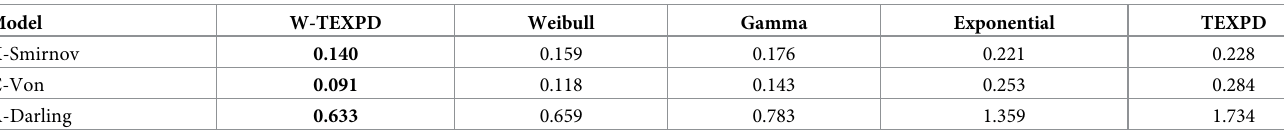
Table 4. Goodness of fit statistic of failure times of 31 air conditioners of airplane.